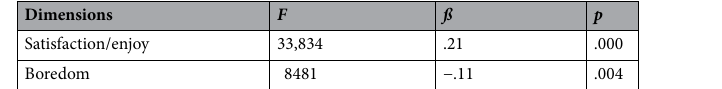
Table 2. Simple linear regression of the CPA (independent variable) predicts the dimensions of the SWS (dependent variable). ß = Standardised beta weights ** p <